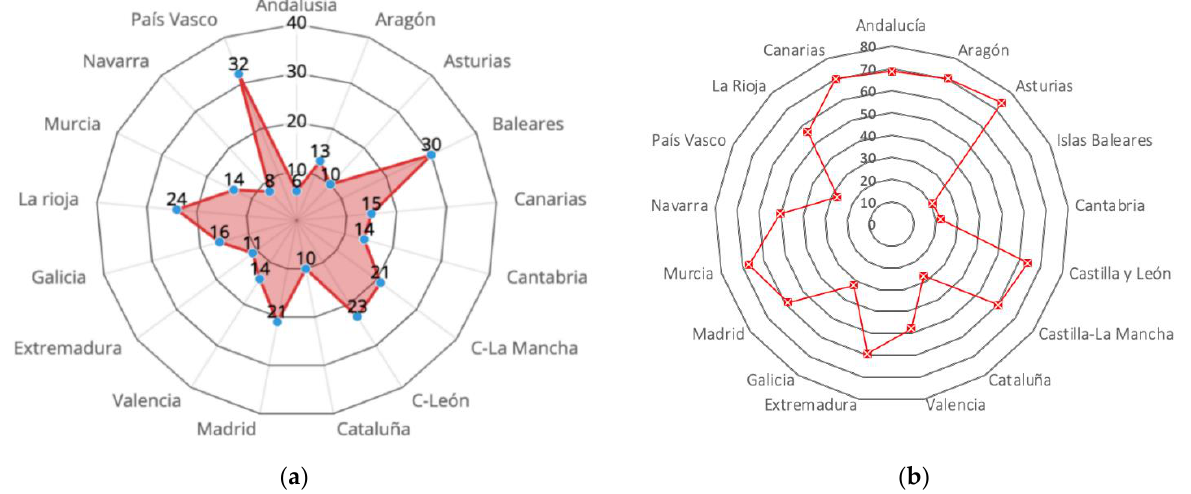
Figure 4. ( a ) Disposal cost (EUR/Ton) in different areas in Spain. Source: own elaboration with data collected from [33]. ( b ) Percentage of waste destined for landfills — source: own development with data collected from [34].